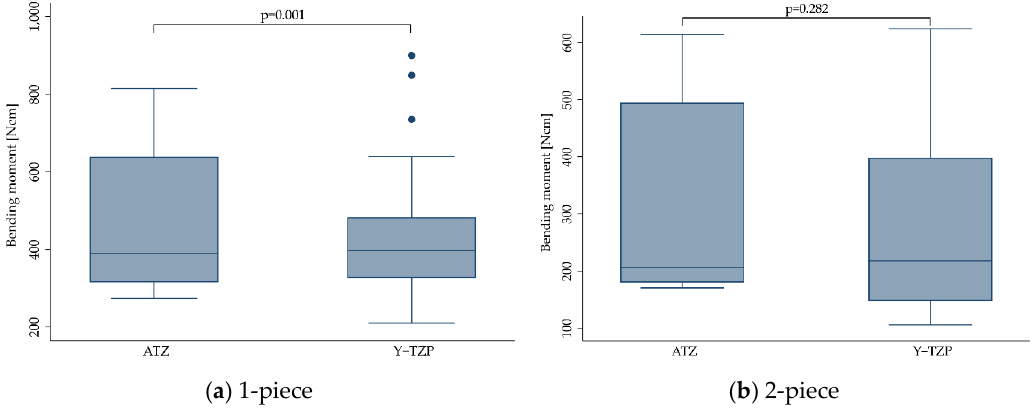
Figure 3. Boxplots showing the bending moment at the time point of fracture depending on the material selection for 1- ( a ) and 2-piece ( b ) zirconia implants. Whiskers are used to represent all samples lying within 1.5 times the interquartile range. Dots represent outliers. Detailed data can be found in Tables 3 and 4.